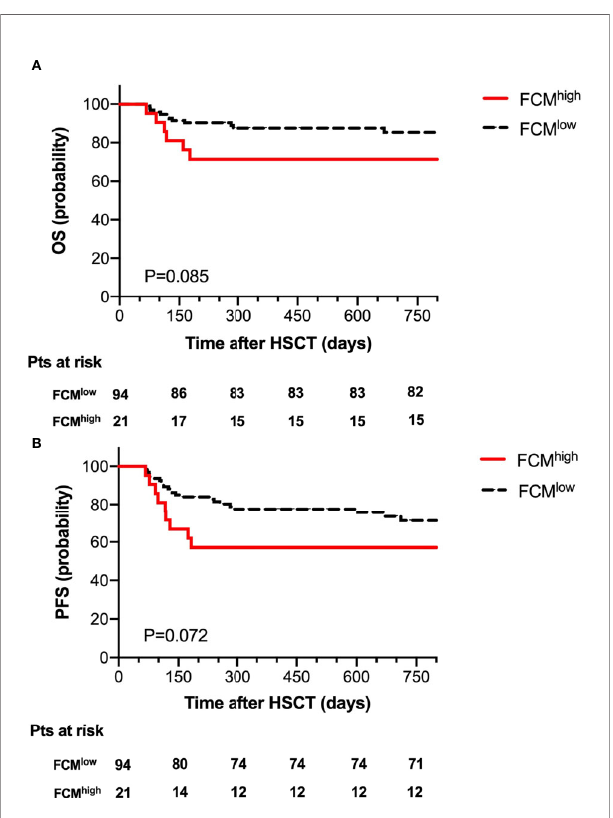
FIGURE 3 | Overall survival (A) and progression-free survival (B) for 115 patients according to mutation clearance analysis.